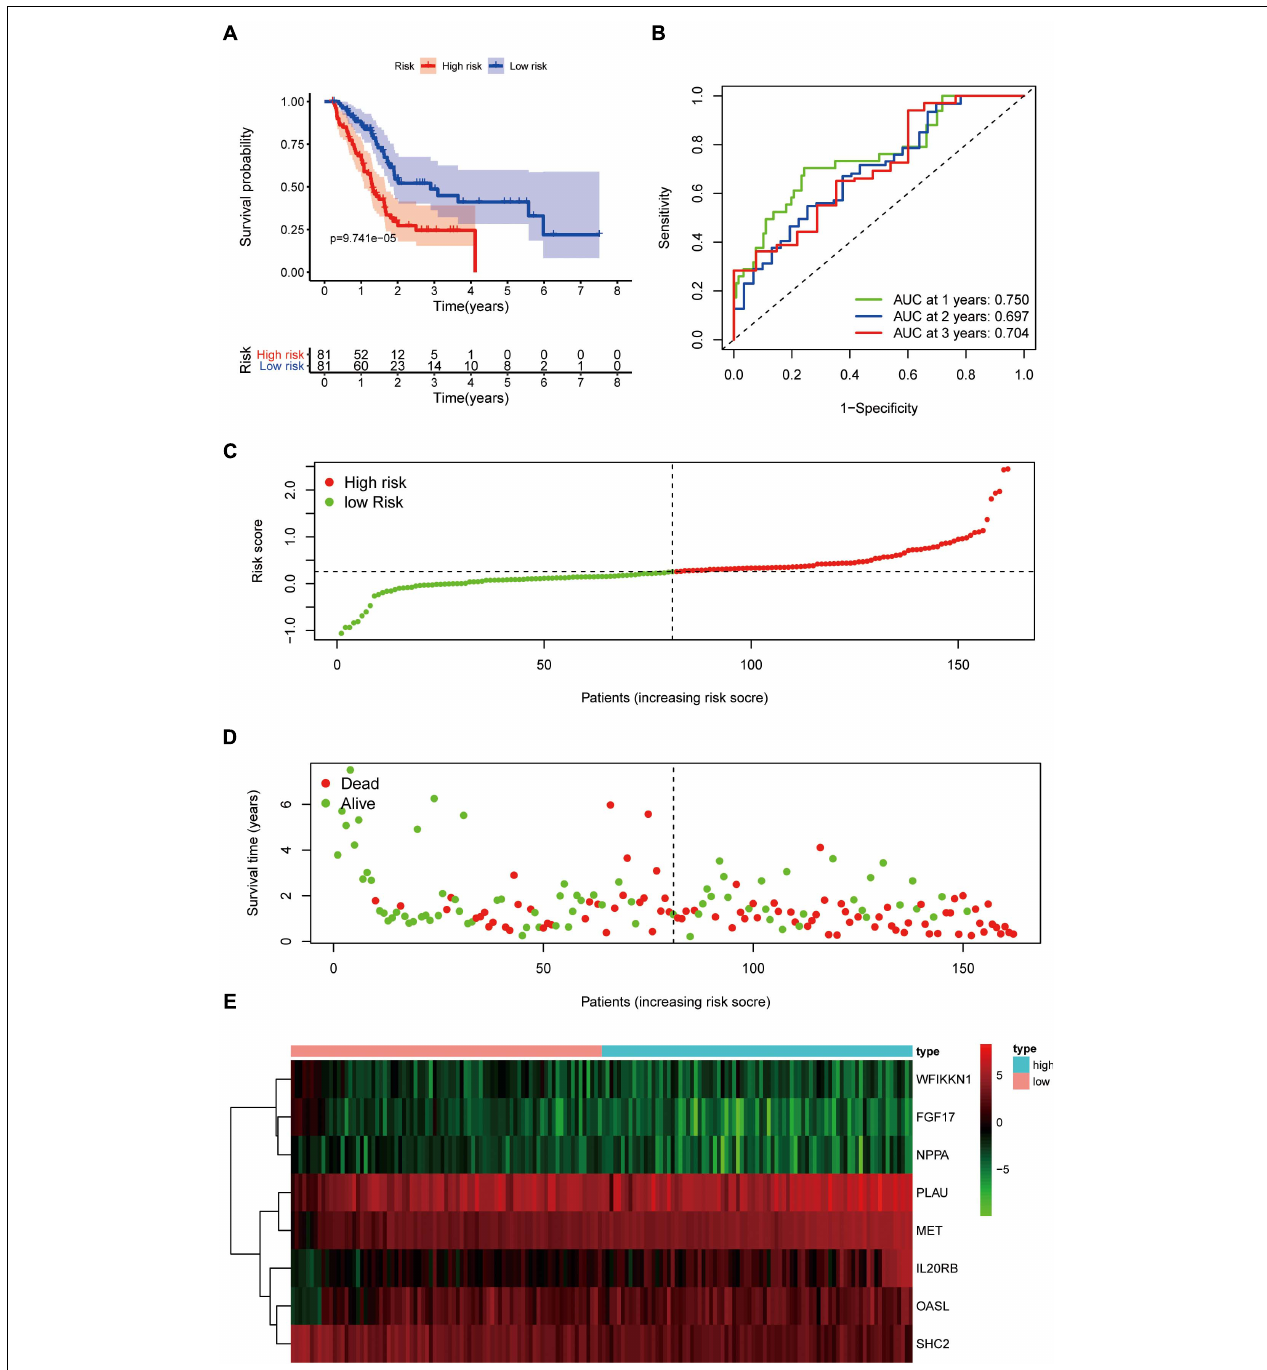
FIGURE 5 | Prognostic value of eight DEIRGs in PAAD patients. (A) Analyses of Kaplan–Meier curves for OS in PAAD patients using the signature of eight DEIRGs. (B) Receiver operating characteristic (ROC) curve suggesting the feasibility of our prognostic model. (C) Patients in high-risk (red dots) and low-risk (green dots) groups and the distribution of their corresponding risk score. (D) Patients in high-risk (red dots) and low-risk (green dots) groups, and their corresponding survival status. (E) Discrimination of expression of eight prognosis-related IRGs between high-risk and low-risk groups as revealed by a heatmap.